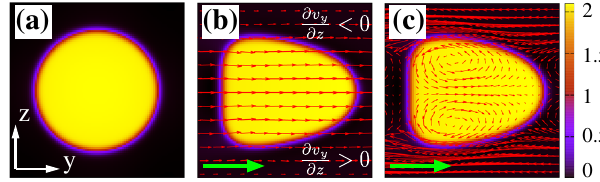
Fig. 1 Steady-state shapes and velocity fi eld structure of a core-free emulsion under Poiseuille fl ow. a Equilibrium con fi guration of a core-free emulsion. b and c Steady-state shapes at Re ’ 3 and Ca ≃ 0.8. Red arrows indicate the direction of the fl uid fl ow computed in the lab frame ( b ) and with respect to the center of mass of the droplet ( c ). Here two eddies rotating clockwise (bottom) and counterclockwise (top) emerge within the droplet. The droplet radius at equilibrium is R = 30 and the color map represents the value of the order parameter ϕ , ranging between 0 (black) and 2 (yellow). This applies to all fi gures in the